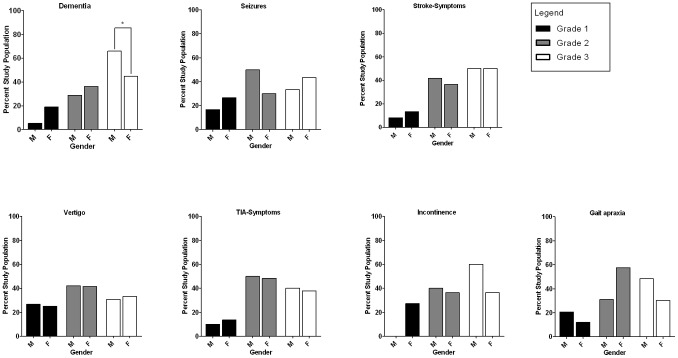
Gender and severity-dependent occurrence of neurological symptoms at admittance.Data from 223 patients, 98 males (M) and 125 females (F) were graded for lesion severity based on CT or MRI scans using the system described by Wahlund, et al., 2001 (Grade 1 =  focal lesions, 2 =  confluent lesions, 3 =  diffuse lesions). With the exception of progressive cognitive decline that occurred more frequently in male patients suffering from Grade 3 WML/lacunar infarcts, symptoms were about equally distributed across severity grades and gender (p = n.s., Pearson's chi square).